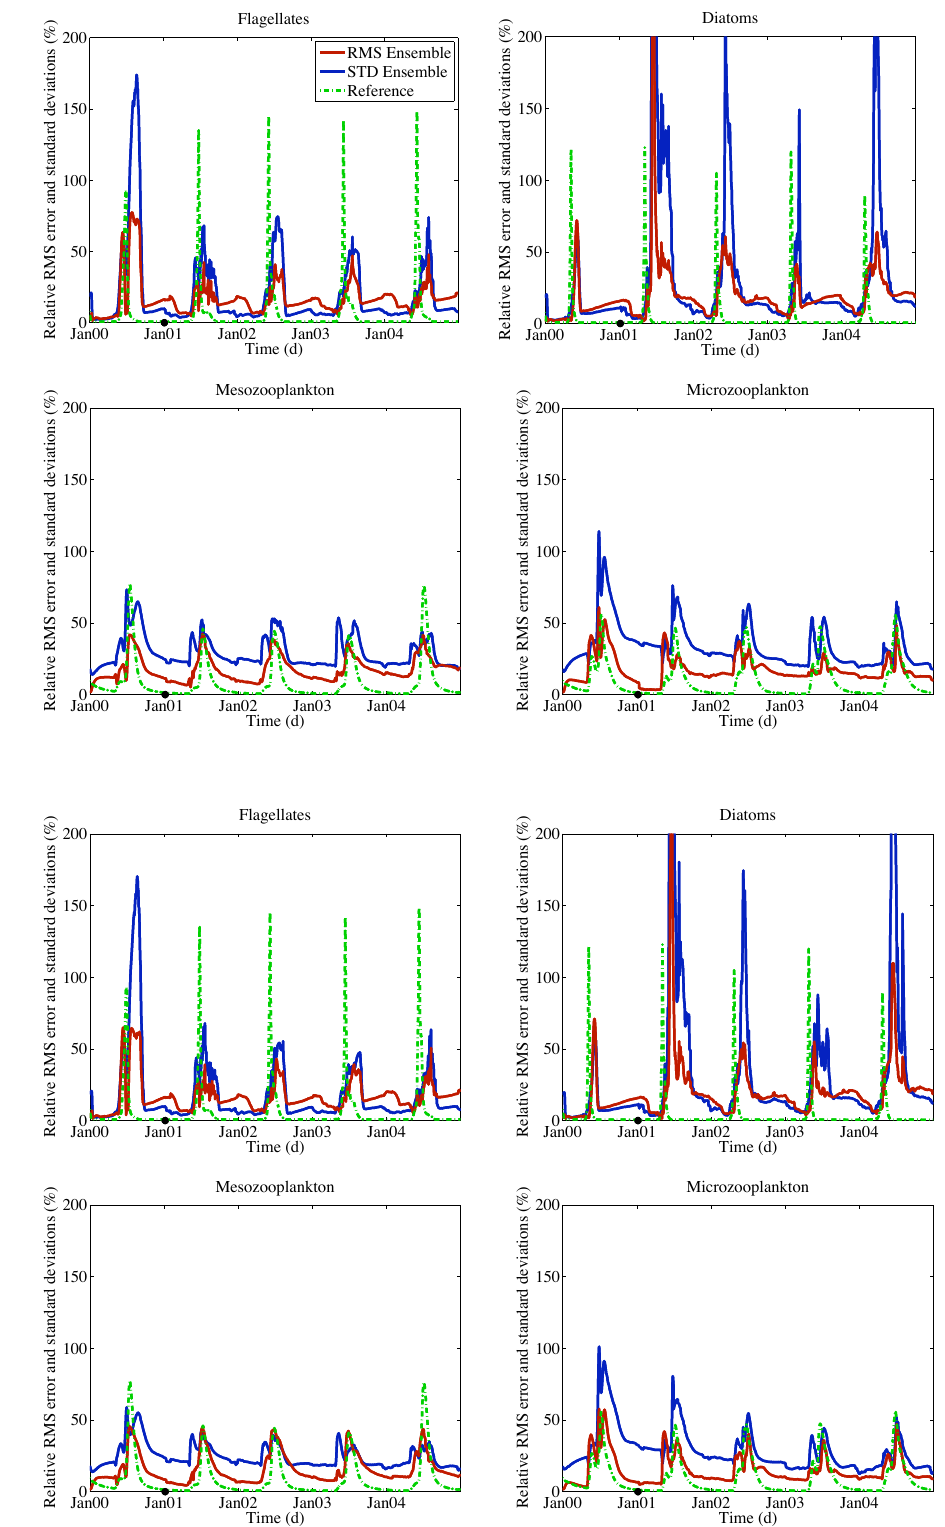
Fig. 3. Evolution with time of the relative RMS error and standard deviation computed over the water column and averaged over the 20 experiments. The spatial mean of the reference solution is plotted to highlight the seasonal dynamics (green dashed curve). The black dot highlights the date of the first